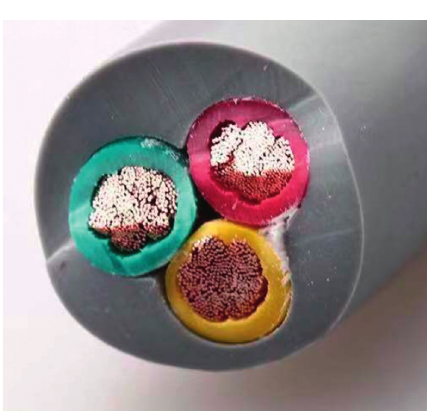
Figure 2: The image of the cable sample.